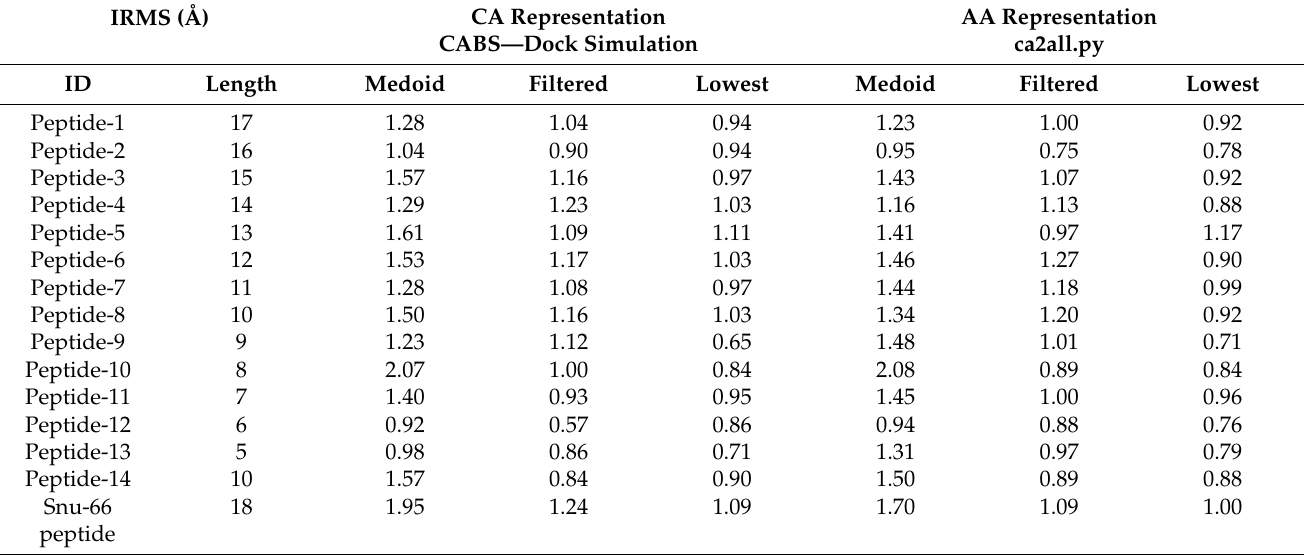
Table 4. Summary table of IRMS